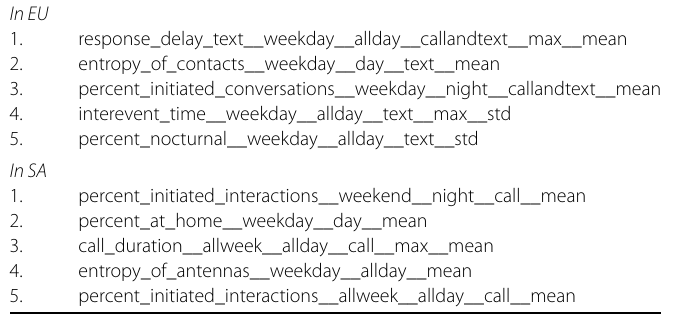
Table 4 Most predictive features in EU and SA according to the Linear SVM with L1 penalty InEU